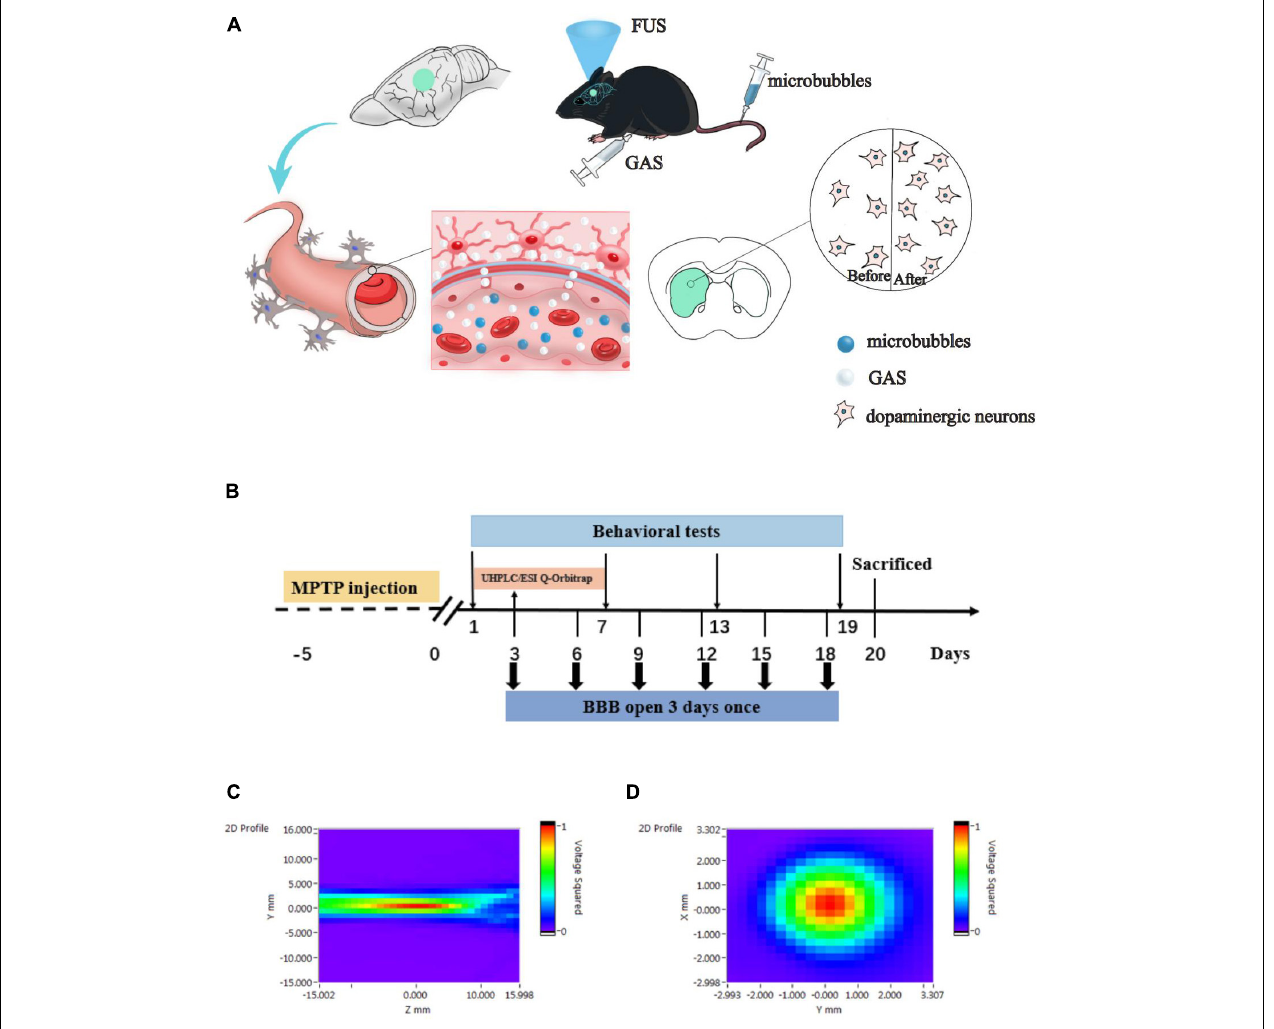
FIGURE 1 | (A) Hypothesis of the delivery of gastrodin (GAS) by focused ultrasound (FUS)-induced blood–brain barrier (BBB) opening. FUS induced BBB opening increased the delivery of GAS to specific brain regions in Parkinson’s disease (PD) mice, thereby enhanced neuroprotective effect on dopaminergic neurons. (B) Details relating to experimental timing including behavioral testing and FUS operation. MPTP, 1-methyl-4-phenyl-1,2,3,6-tetrahydropyridine; UHPLC/ESI Q-Orbitrap, ultra-high performance liquid chromatography electrospray Q-Orbitrap mass spectrometry. (C,D) Acoustic pressure distribution of the lateral and axial